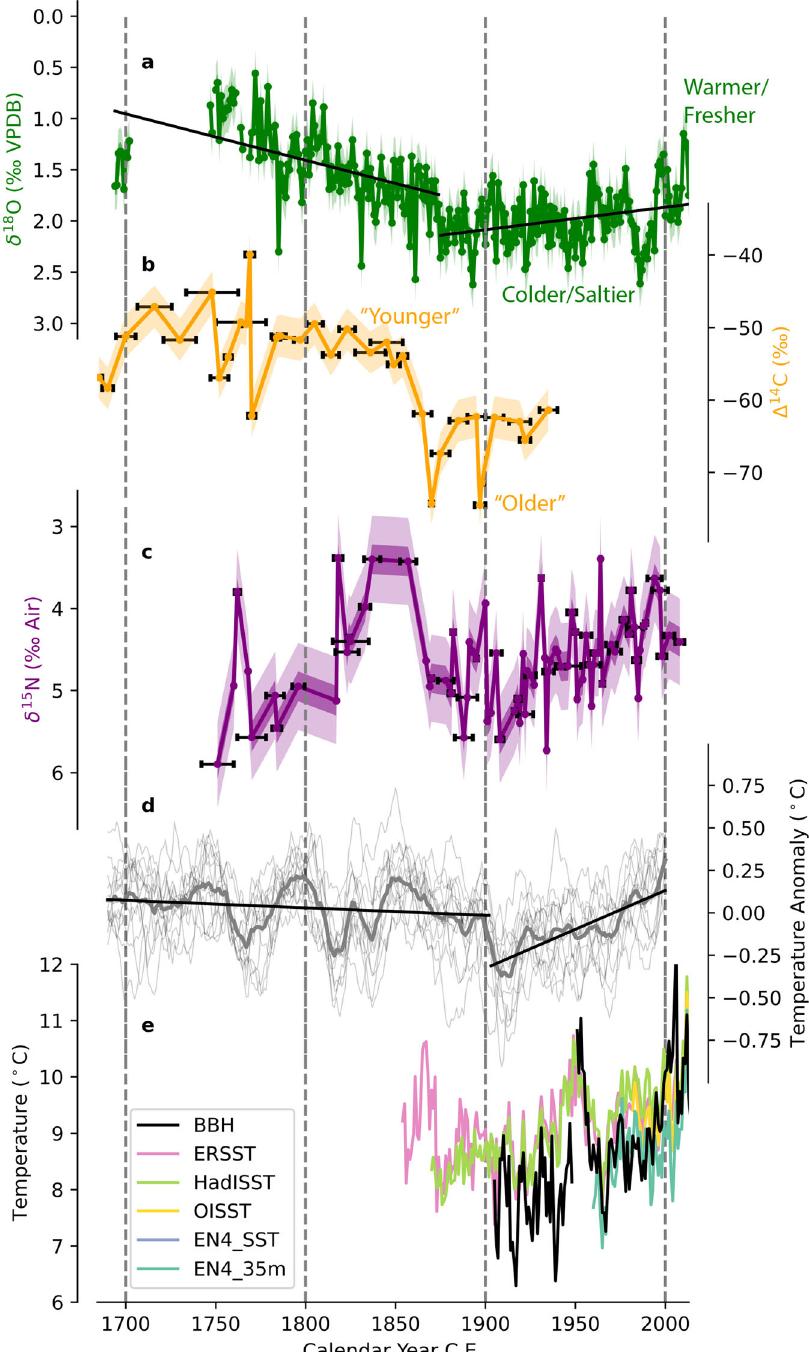
Fig. 2 Geochemical, climate model, and instrumental time series. a Oxygen isotopes measured in Arctica islandica shells. Markers are the average value for that year. Black lines show the result of the segmented regression analysis. Light shading shows the average 1 σ of the data, calculated from those years when more than one shell was sampled, darker shading shows the average 1 σ analytical uncertainty. Note that the y -axis is inverted. b The age-corrected radiocarbon record, originally published in Lower ‐ Spies, et al. 17 . Horizontal error bars represent the amount of time incorporated in each sample. Shading shows the average 1 σ analytical uncertainty. c The nitrogen isotope record. Data after 1926 was previously published in Whitney, et al. 26 . Markers are the average value for that year. Horizontal bars represent the amount of time incorporated in each sample. Light shading shows the average 1 σ of the data, calculated for those years when more than one shell was sampled, darker shading shows the average 1 σ analytical uncertainty. Note that the y -axis is inverted. d The CESM-LME Gulf of Maine annual temperature anomaly time series, calculated at 35 m depth. Anomalies are calculated using the average of the entire record shown here. The bold line is the ensemble member mean, the thin lines show each of the 13 ensemble members with full transient forcing. The linear regression lines show the result of the segmented regression analysis on this record. e Temperature from instrumental records (BBH) and gridded data products (ERSST 31 , HadISST 32 , OISST 34 , EN4 36